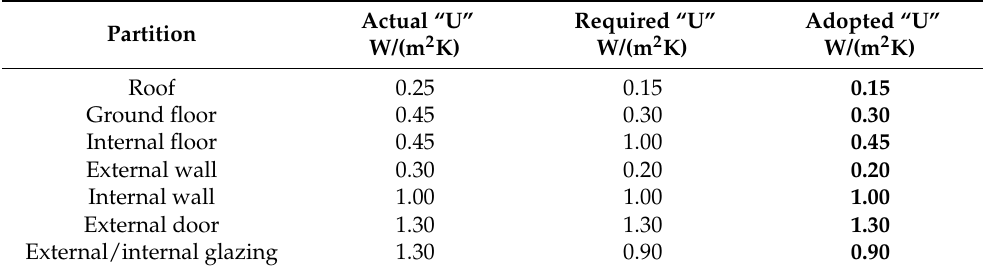
Table 4. Comparison of heat transfer coefficient